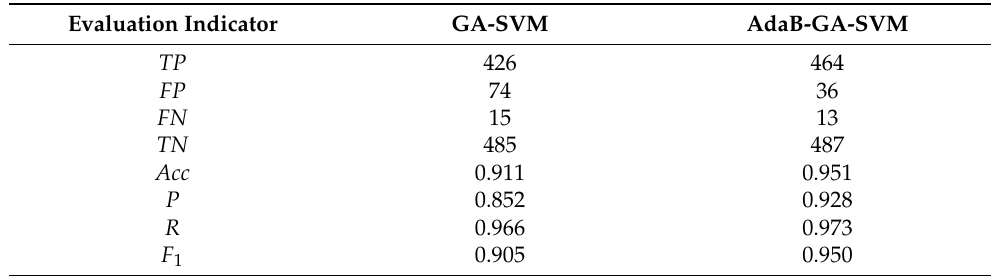
Table 3. The results of the GA-SVM model and the AdaB-GA-SVM model when tested with the aforementioned test set.